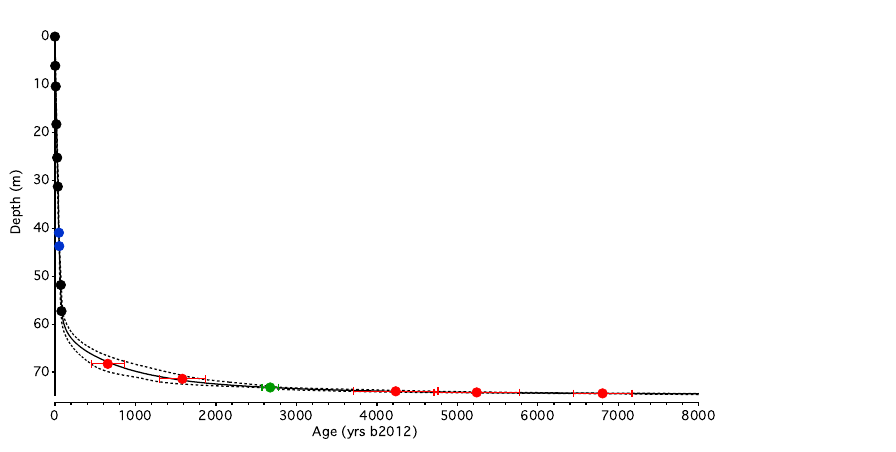
Figure 11. Construction of the Mt. Ortles ice core timescale. Age–depth relationship based on 2000 Monte Carlo realizations (continuous black line; dotted lines indicate the 1 σ confidence interval) fitting the absolute dated age horizons. Dots denote the surface and 210 Pb ages (black); the tritium 1963 and beta 1958 peaks (blue); the calibrated 14 C WIOC ages (red) and the calibrated 14 C age of the larch leaf (green), all shown with their respective 1 σ uncertainty (data are presented in Table